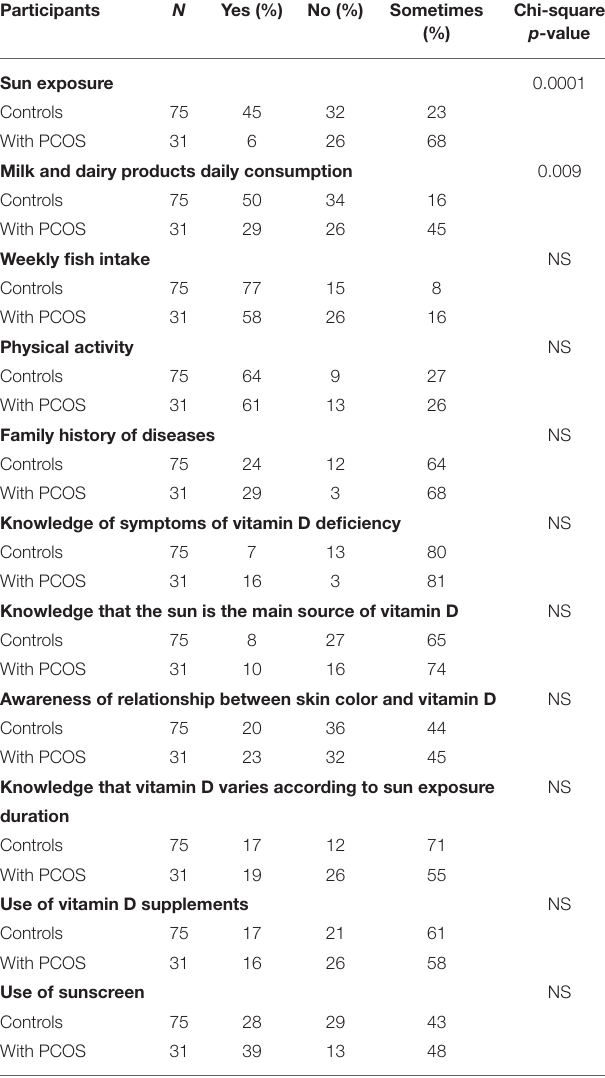
TABLE 3 | Responses to lifestyle and dietary questionnaire by women with PCOS and controls. Participants Sometimes